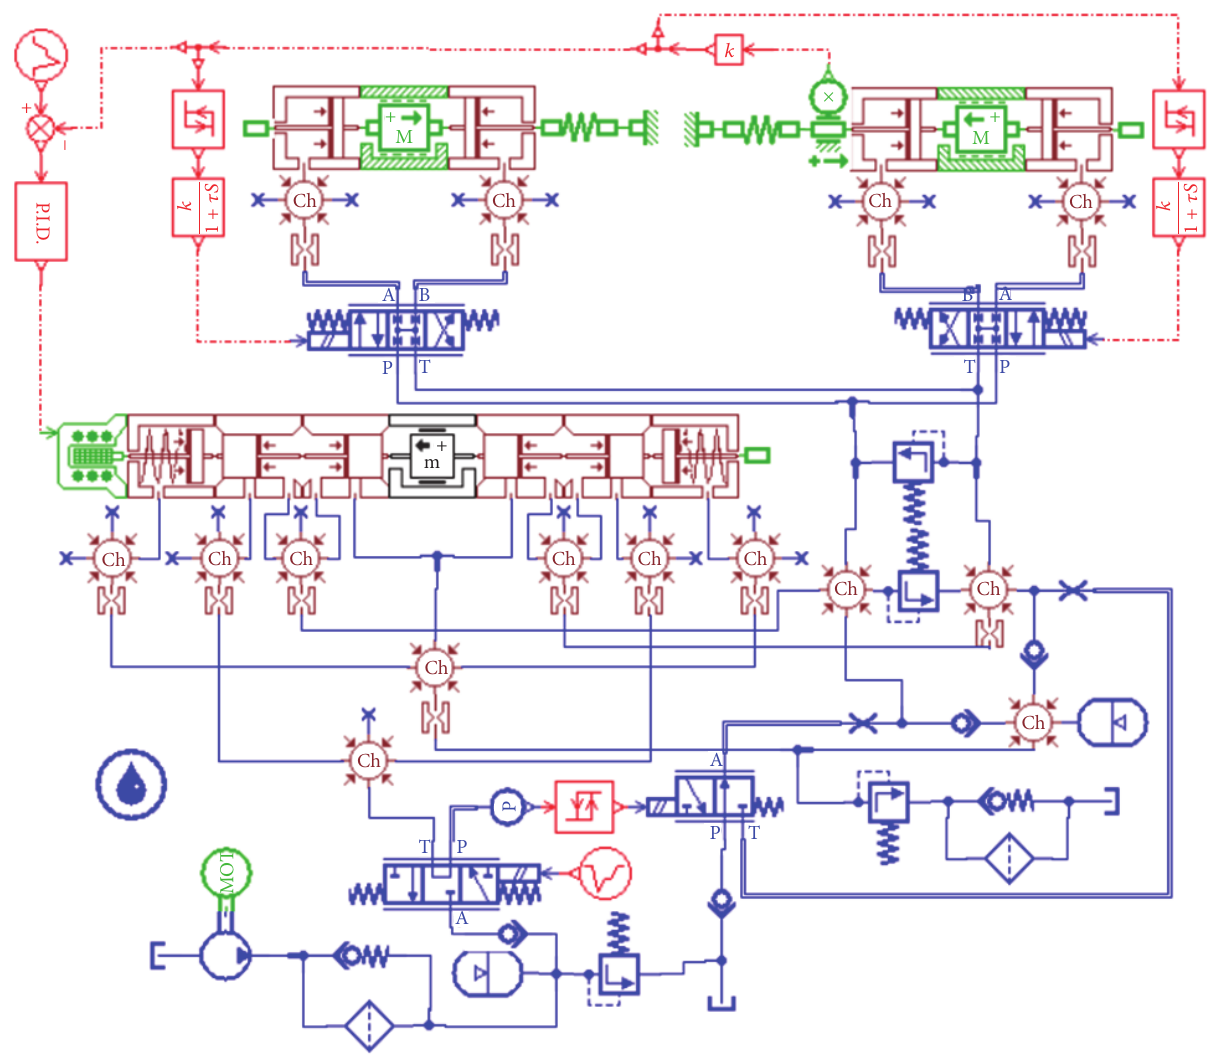
Figure 12: Simulation model of the dual actuator nose wheel steering system.